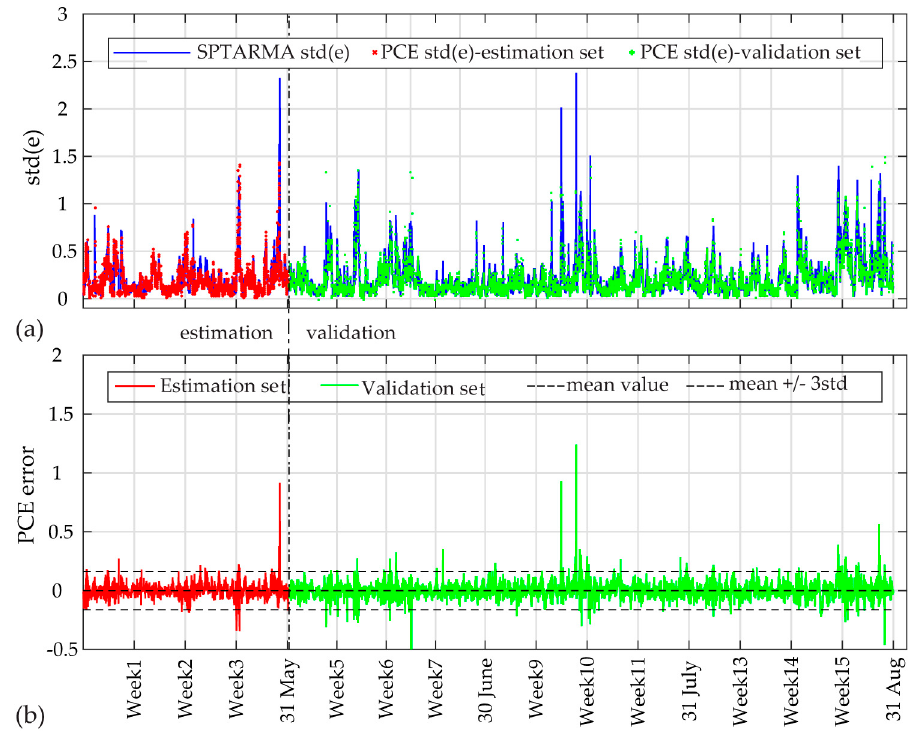
Figure 17. PCE estimates for Case B: ( a ) std of SP-TARMA(18,18,1,0.0001) model residual and PCE model expansion values; ( b ) The PCE errors along with 99.7% confidence intervals (calculated for estimation set).